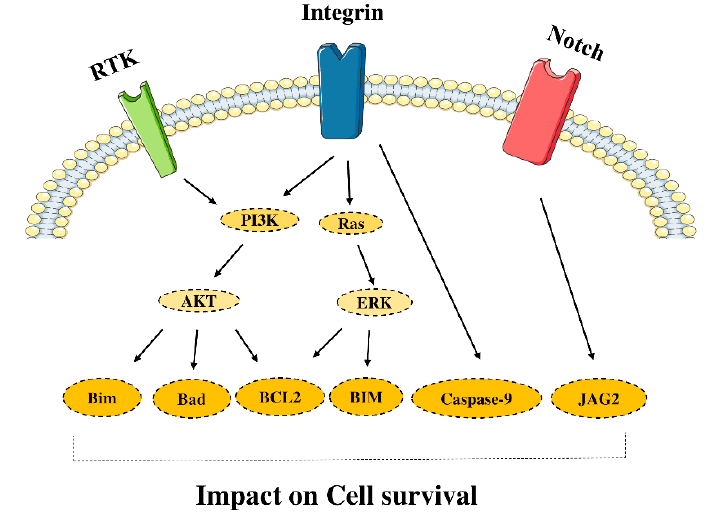
Figure 2. Signaling pathway and cell survival. Escape from cell death is one of the mechanisms to bypass anticancer treatments. The key players in preventing apoptosis are known as survival proteins. The figure was produced using Servier Medical Art (http://smart.servier.com/) (assessed on 2 January 2020).